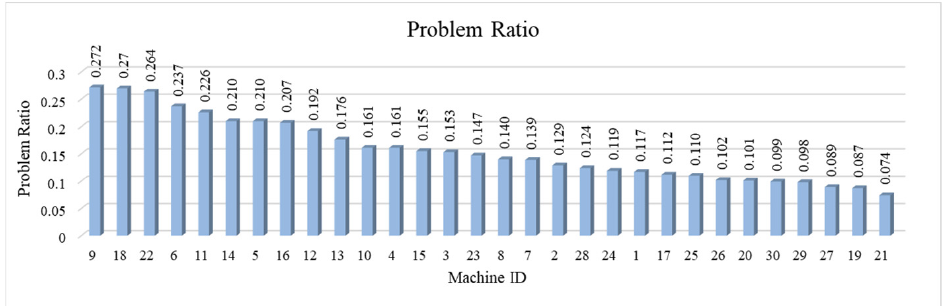
Figure 3. The problem ratios of machines.